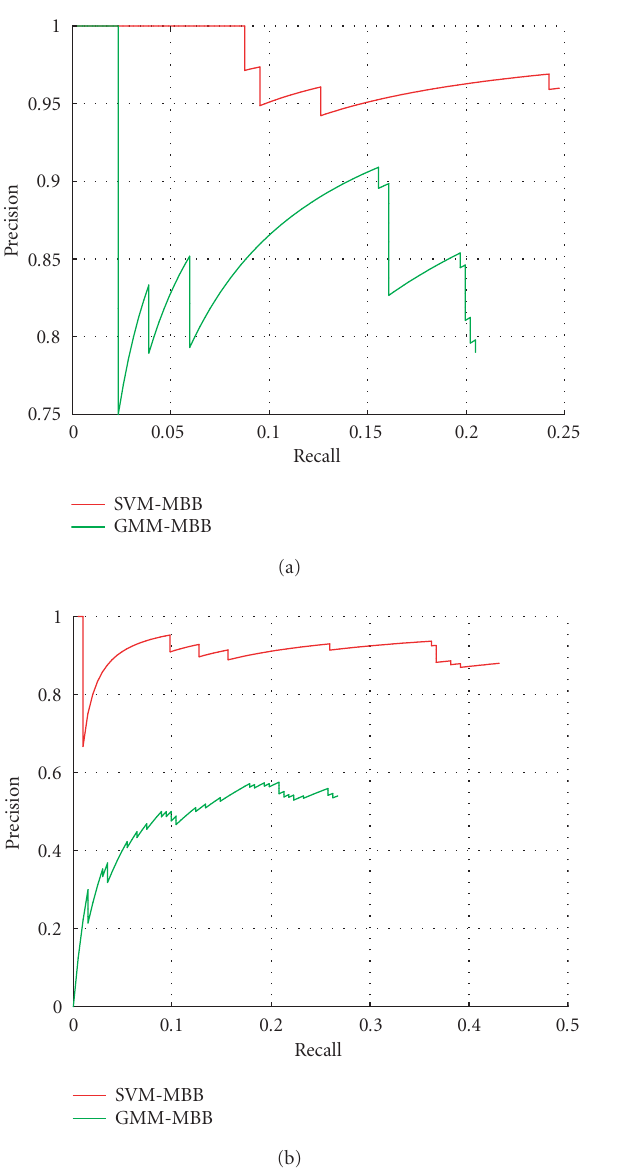
Figure 5: Precision-recall comparison between SVM and GMM (a) Outdoors (b) Sky.